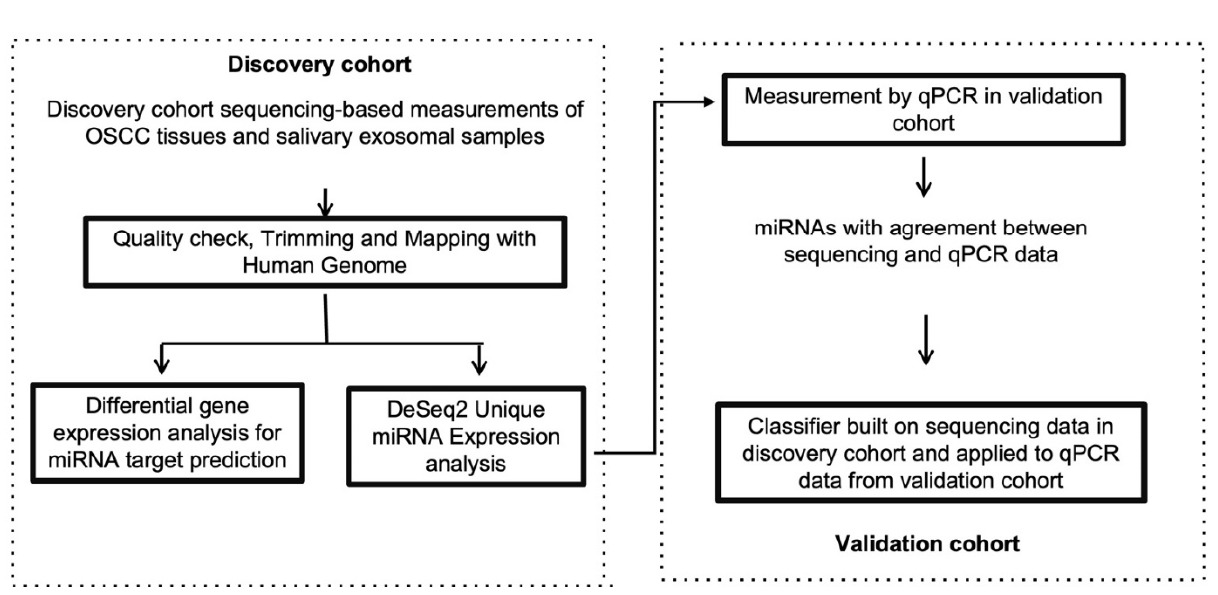
Figure A1. OSCC patient sample cohorts. Text without boxes denotes miRNA and mRNA sets. Boxes with solid lines denote analytical operations.